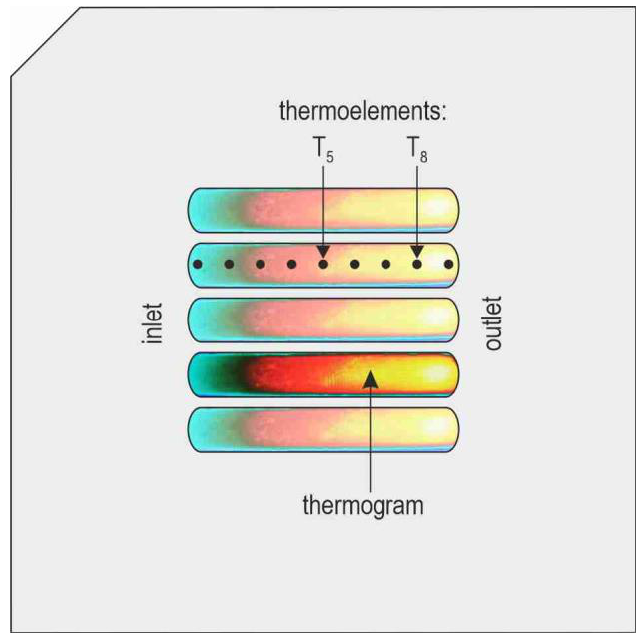
Figure 4. The test section – top view showing mini-channels selected for statistical analysis of temperature measurement data; the selected points for temperature measurement realized on the heated wall surface are indicated.